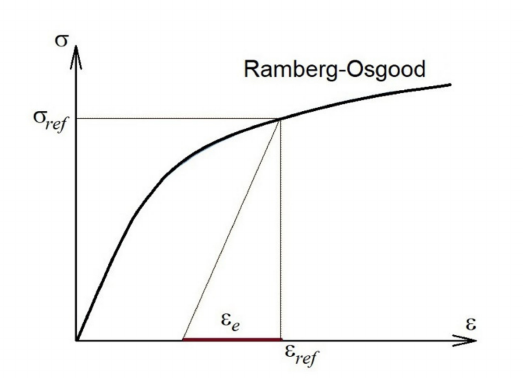
Figure 3. Ramberg–Osgood stress–strain diagram and denotation of the quantities